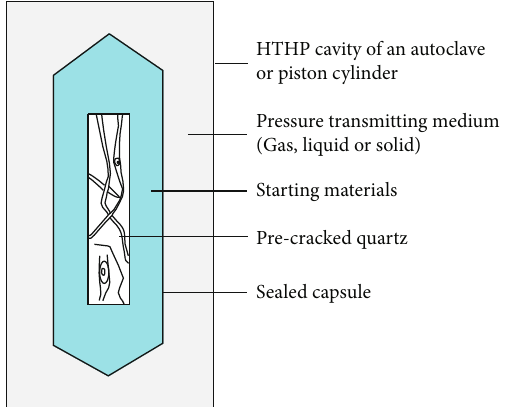
Figure 1: Sketch of the fl uid inclusion synthesis within high- temperature and high-pressure equipment (not